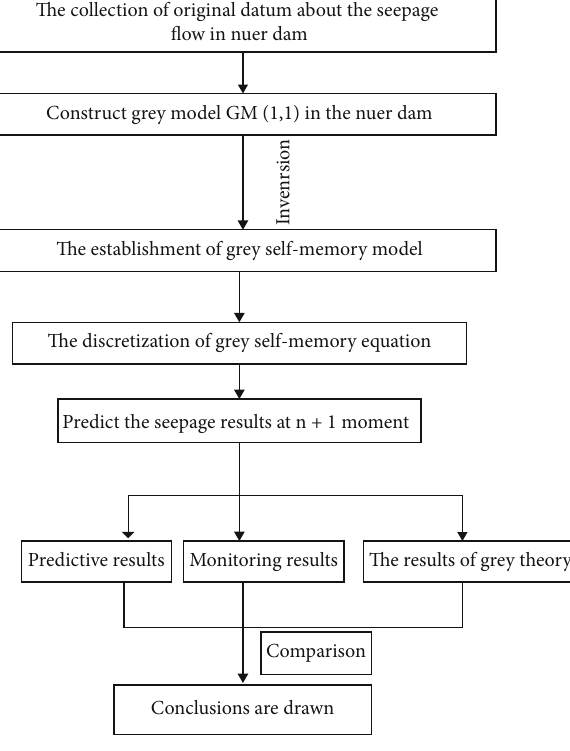
Figure 7: The fl owchart of seepage prediction